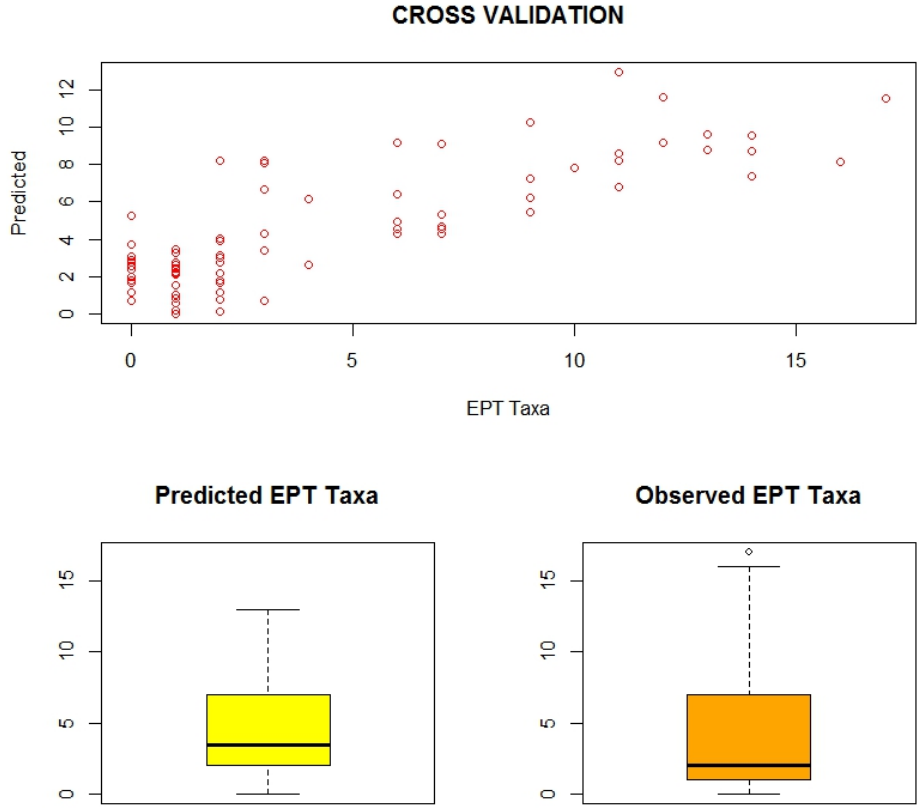
Figure 4. Scatterplot and box plot comparison of predicted number of dominant EPT Taxa resulting from cross-validation of ridge regression model (Predicted EPT Taxa) of six morphology combined with three watershed variables after variable elimination compared with measured (Observed EPT Taxa) number of dominant EPT taxa values for 79 restored streams. Predicted values have been truncated at zero.